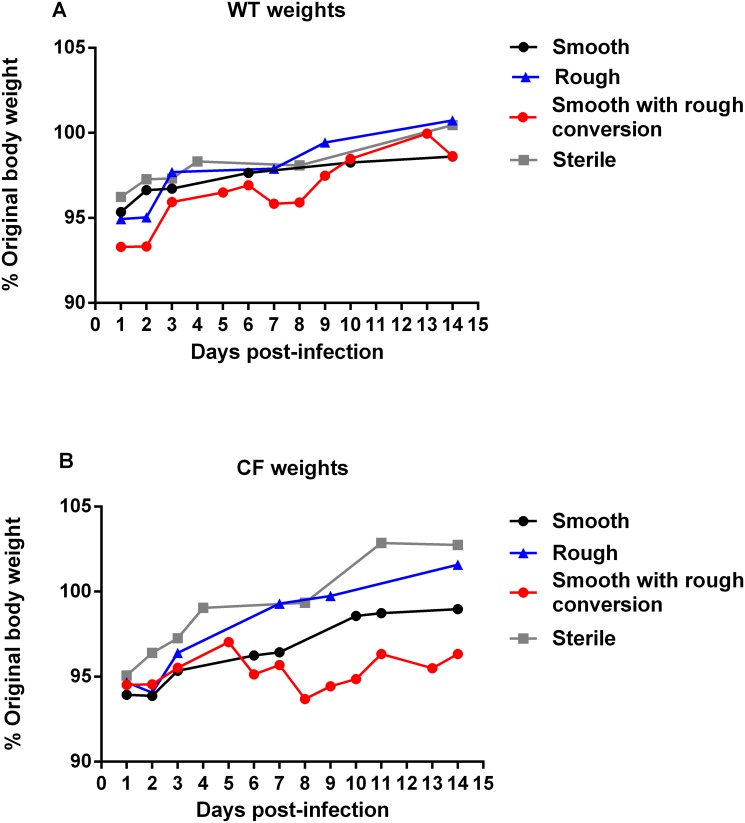
Weight trends.(A and B) Mice inoculated with M. abscessus trended towards greater weight loss than mice inoculated with sterile thrombin/ fibrinogen. (N = 19–40 mice in each M. abscessus group, N = 6–16 mice in each sterile inoculum group). Mice receiving smooth morphotype inoculation that had some colony conversion to rough morphotype on either BALF, lung, or spleen cultures had trend towards greater weight loss and slower weight gain. (N = 8–10 for WT mice, 4–6 for CF mice). Data displayed as mean of group, pooled from 2–3 replicate experiments for each morphotype.